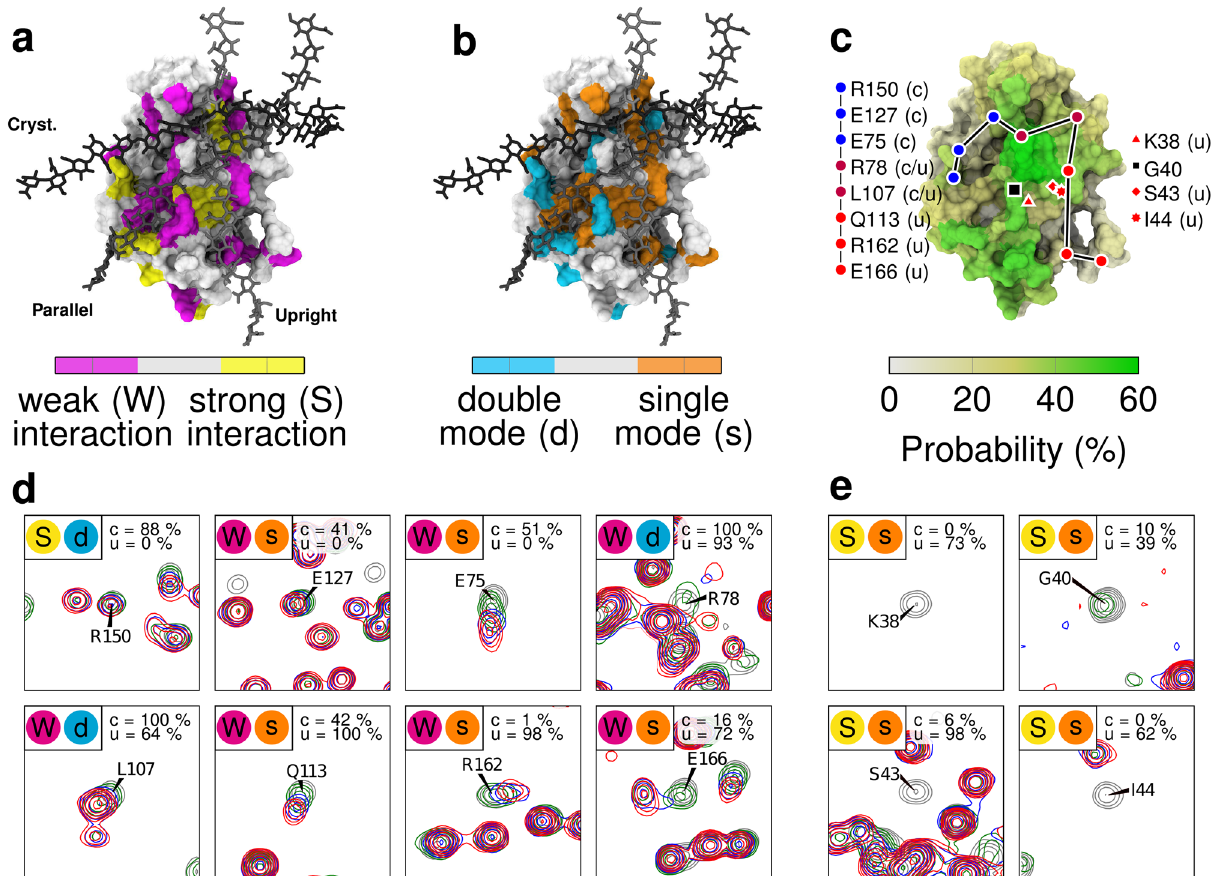
Figure 5. NMR titration of CD44-HABD by hyaluronate hexamer. Structures shown in a, b, and c are extracted 15 1 from our previous study, where the CD44 coordinates are based on PDB:1UUH. ( a ) Selected N/ H HSQC signals are sorted in two groups—residues with an immediate shift/disappearance of the signal, i.e., strong interaction (yellow color), and residues with a gradual shift, i.e., weak interaction (magenta color). ( b ) The signals are sorted in two groups — residues with a single signal, i.e., single binding mode (orange color), and residues with a doubled signal, i.e., double binding mode (cyan color). Hyaluronate hexadecamers are shown in three possible binding modes distinguished by shades of gray– the crystallographic (cryst.) , parallel (parallel) , and upright (upright) mode. ( c ) Hyaluronate-perturbed residues in simulations. The colored surface displays the probability of a given residue to be in contact with HA6 in our simulations (G5 in Table 2). Filled circles highlight the positions of selected residues from both the crystallographic and upright modes, which were perturbed by hyaluronate binding in our NMR experiments (cf. d ). These marks are also colored based on the predominant binding mode of the highlighted residues in our earlier simulations 14 . Lines between the residues are drawn to guide the reader. The position of residues belonging to the R41-containing binding epitope is also shown (cf. e ). Fig. S5 in Note SF shows similar surface data for both hexamer systems (Systems G5 and 15 15 15 1 G6 in Table 2) ( d ). ( e ) Selected N/ H HSQC signals are shown for free N-CD44-HABD (grey), N-CD44- HABD with equimolar hyaluronate hexamer (green) and twofold (blue) and a threefold (red) molar excess of hyaluronate hexamer. Colored circles (top left) indicate to which category the residue falls in ( a,b ). Probability of a given residue to interact with HA in each binding mode in our earlier simulations 14 is indicated in the top right corner of each